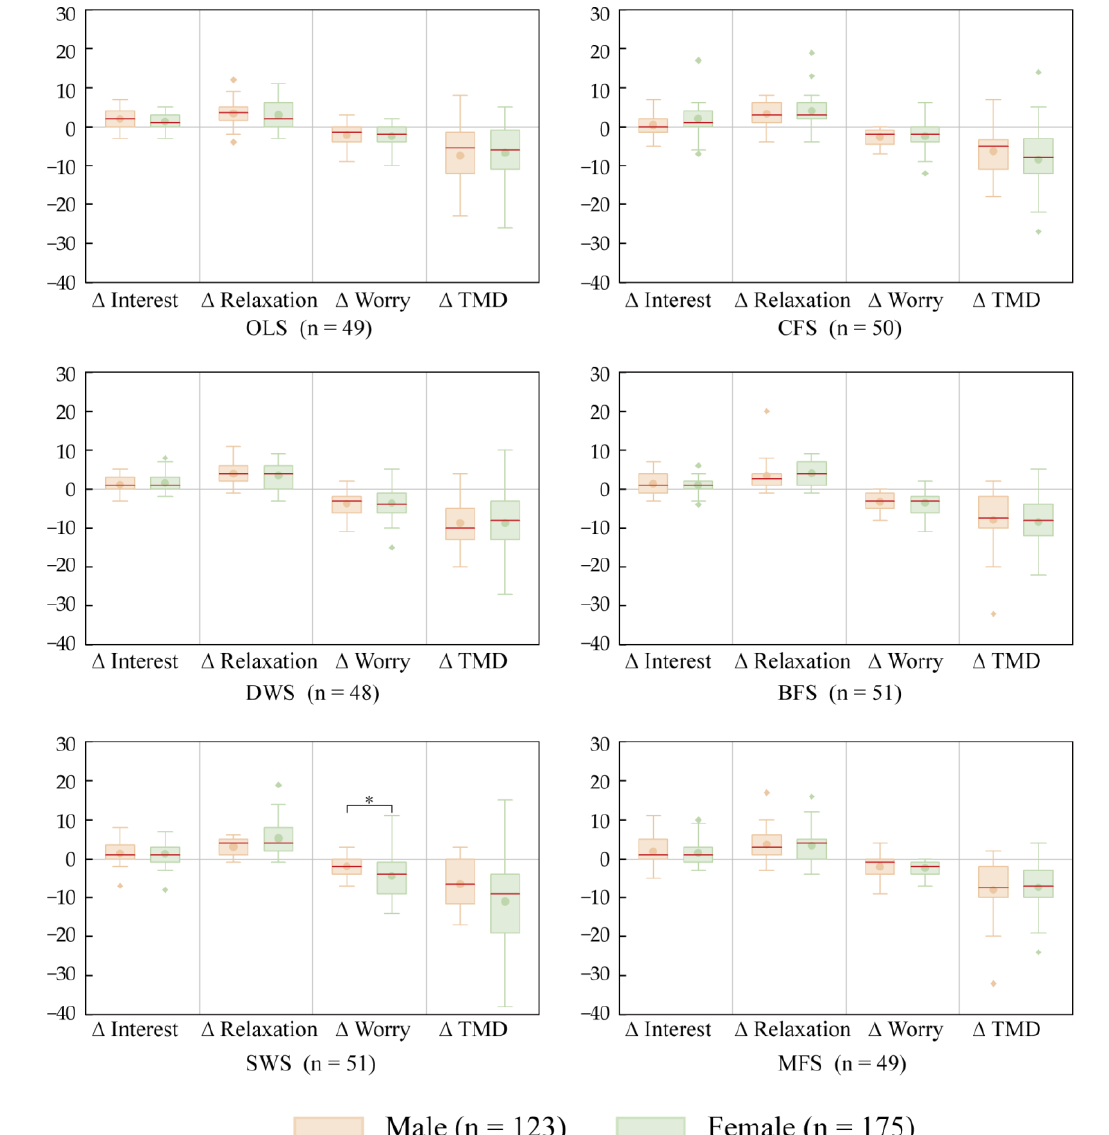
Figure 6. Differences in emotional response changes in participants of different gender in each forest landscape space. * p < 0.05. OLS: overlook of the landscape space ( n = 49); DWS: dynamic water landscape space ( n = 48); SWS: static water landscape space ( n = 51); CFS: coniferous forest landscape space ( n = 50); BFS: broadleaf forest landscape space ( n = 51); MFS: mixed forest landscape space ( n = 49).